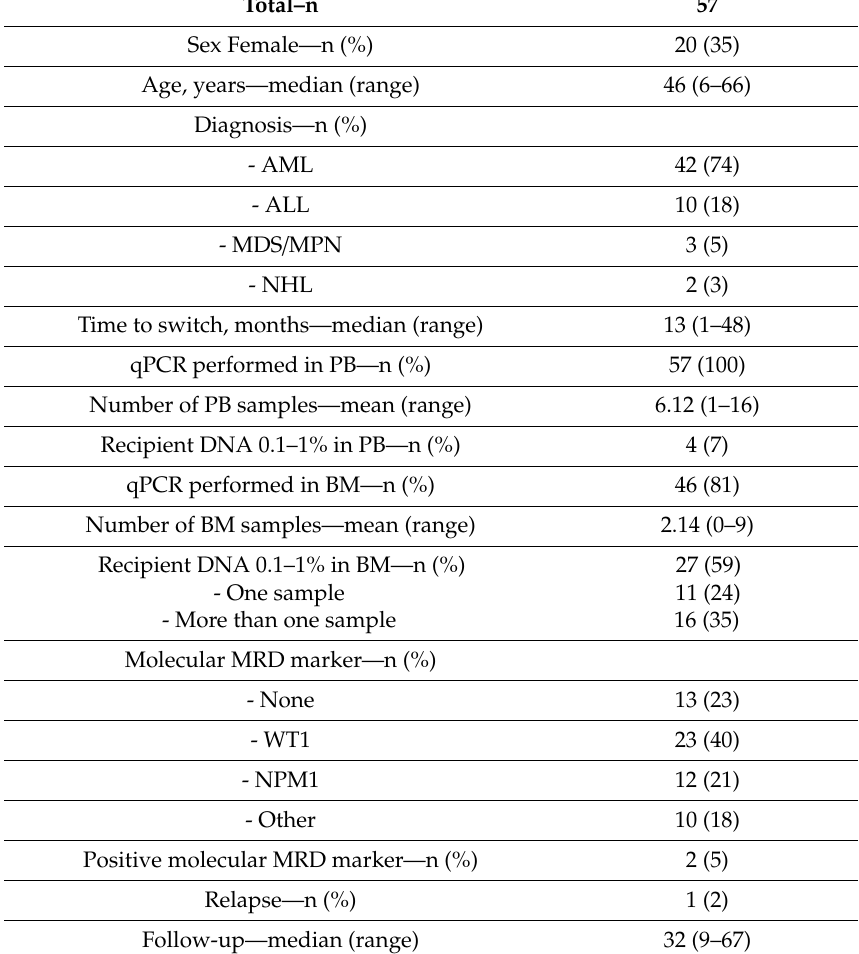
Table 1. Patient characteristics, chimerism follow-up and outcome. ALL: Acute Lymphoblastic Leukemia; AML: Acute Myeloid Leukemia; MDS / MPN: Myelodysplastic Syndrome / Myeloproliferative Neoplasm; NHL: Non-Hodgkin